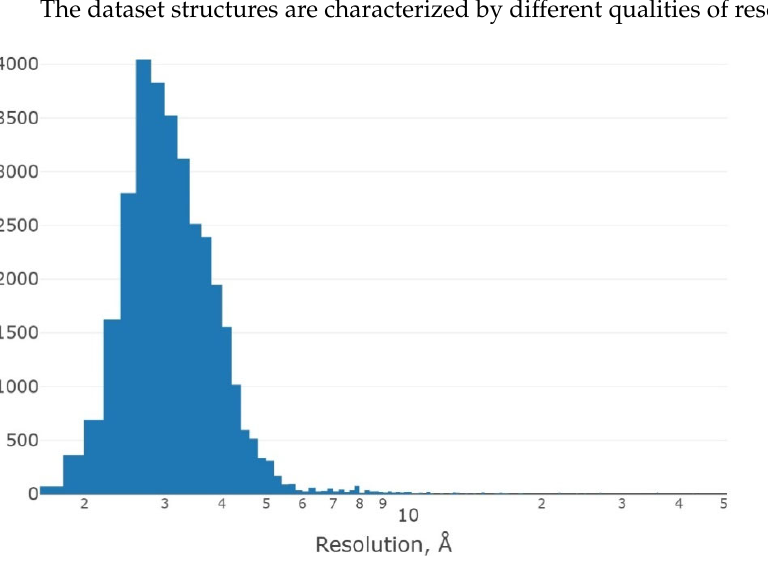
Table 2. Methods of protein 3D ‐ structure determination experiments used to recognize and segment 3 β‐ corners and 3 β‐ corner ‐ like structures.